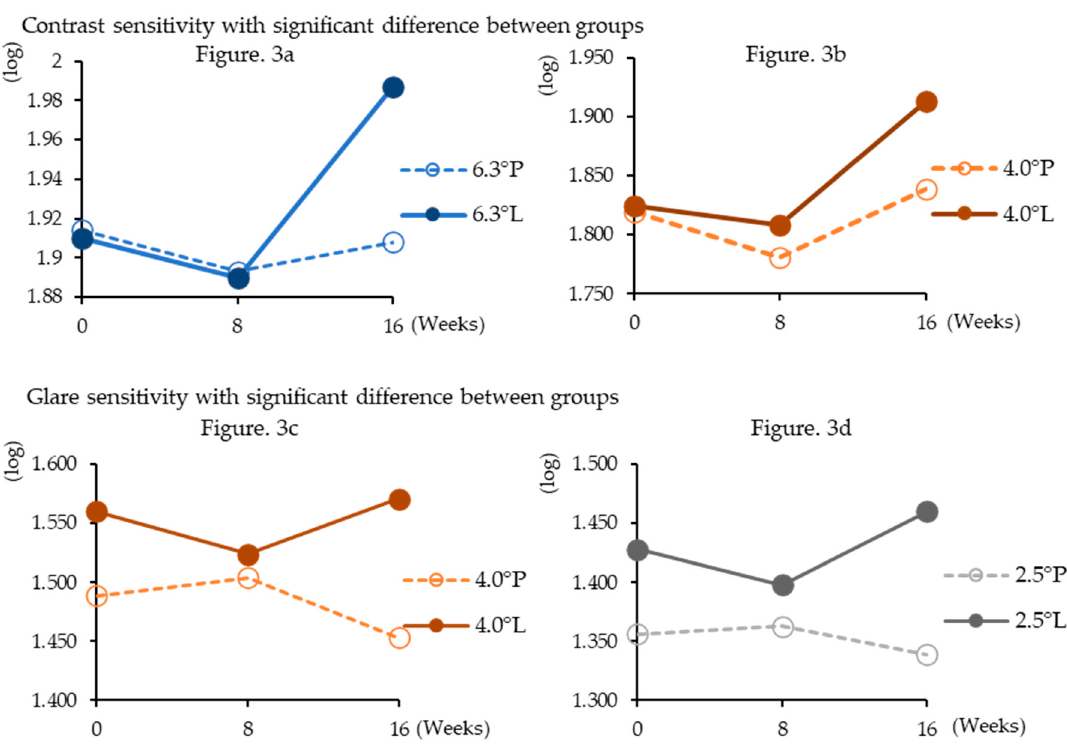
Values are presented as means ± standard deviations. “ n ” indicates number of eyes. Statistical